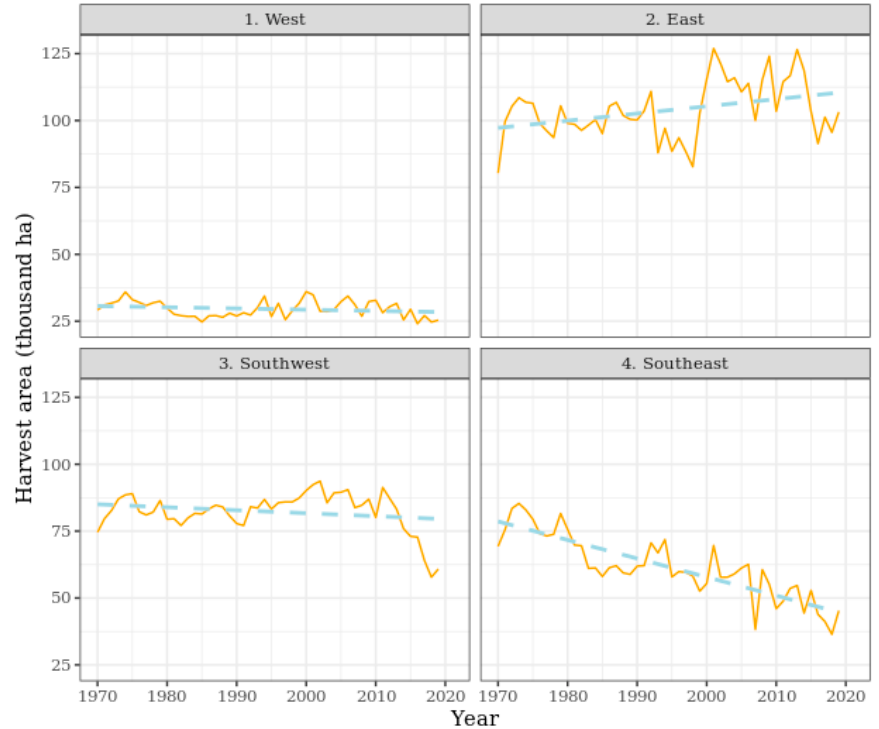
Figure 4. Total harvest area of maize in the four investigated regions of Hungary (1970–2019). Table 1. Results of the Shapiro–Wilk